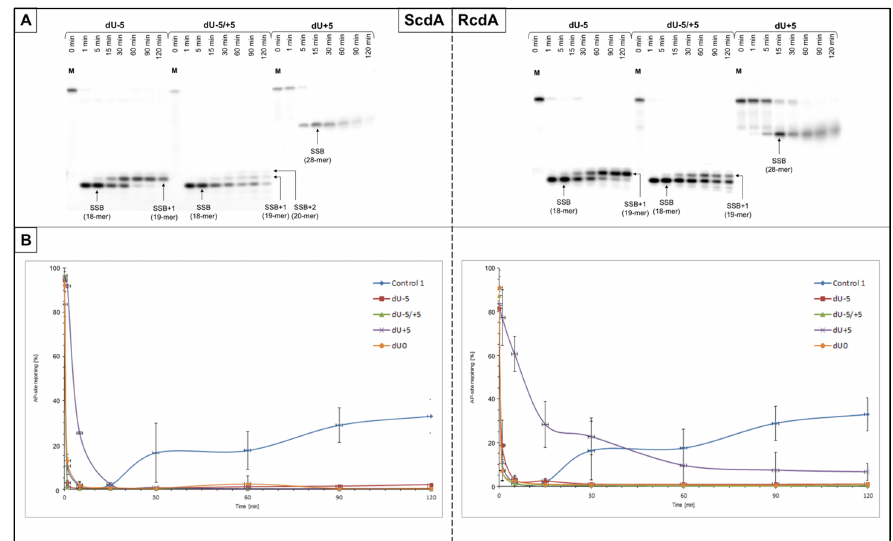
Figure 2. ( A ) The representative autoradiograms presenting stages of nuclear BER in XPC cell line (the strand incision, elongation, and repair) of dsDNA containing single-stranded clustered DNA lesions (ssCDL) with AP site and ScdA or RcdA on one strand distanced by 5 base pairs in 5 ′ -end direction (negative numbers) or 3 ′ -end direction (positive num- bers); M—length marker (40-mer dsDNA with a single AP site); SSB—single-strand break (AP site cleavage resulting from the endonucleolytic activity of nuclear extract); SSB+1/SSB+2—cleaved strand with 1 or 2 nucleotide unit incorporated (resulting from polymerase activity of nuclear extract). Each experiment was performed three times for consistency. ( B ) Graphical representation of the AP site rejoining trends (strand reconstitution). Graphs in higher resolution and autoradi- ograms of all experimental repeats are available in the Supplementary Materials.